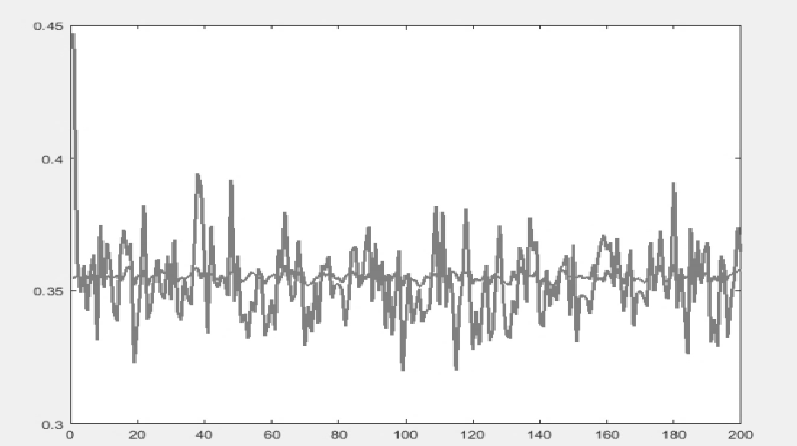
Fig. 5. Convergence of the solutions obtained from the algorithm for the second objective function (cost).